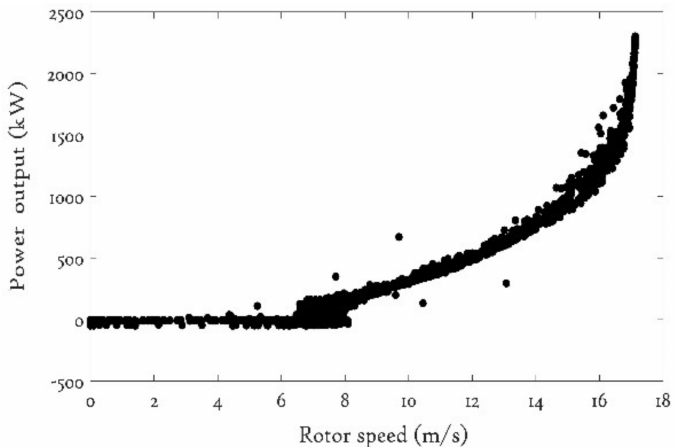
Figure 4. Measured rotor power curve.